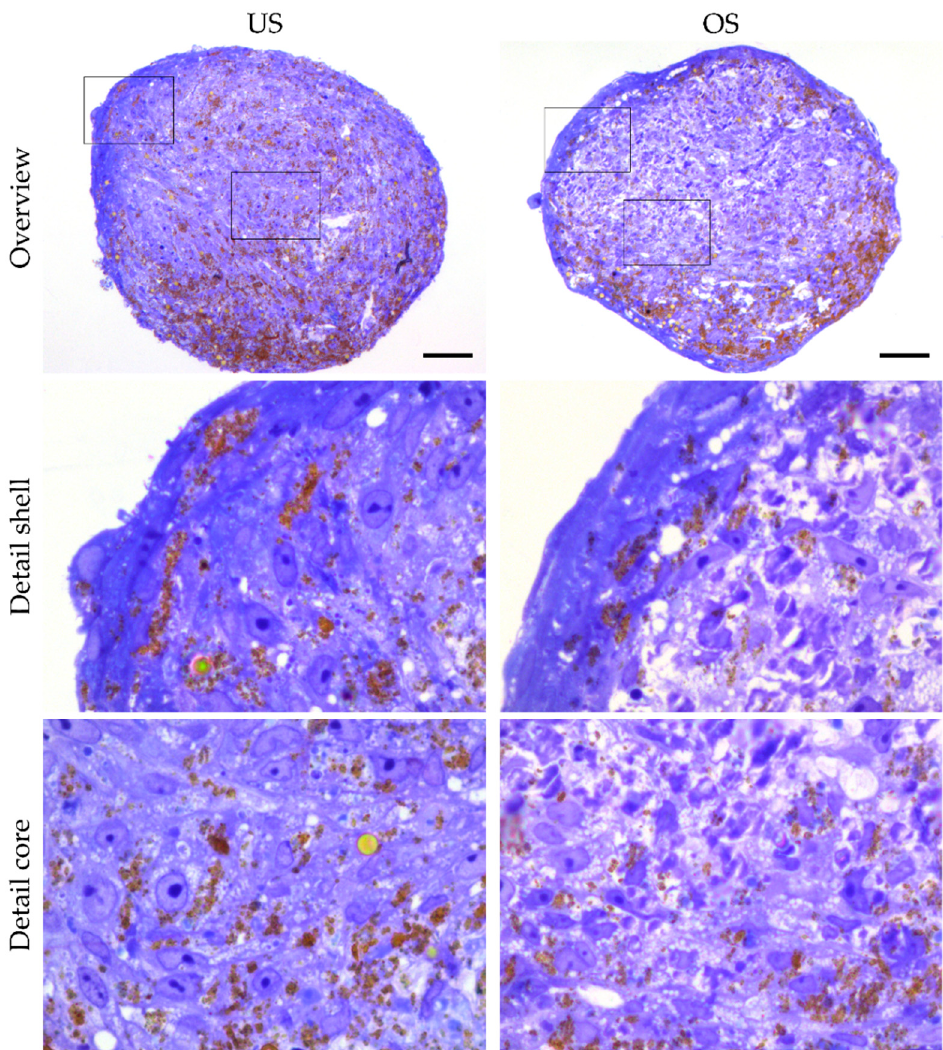
Figure 4. Representation of 3D spheroids by overview staining of thin sections with toluidine blue. Overview images of an unstimulated (US) spheroid and an osteogenically (OS) stimulated spheroid after 14 days ( top panel). Frames in the overview images correspond to the areas shown below in high magnification. Details of the shell and core regions of the same spheroids show differences in cell arrangement, cell shape, and cellular spacing ( middle and bottom panels) (scale bars represent 50 µm for the overviews and 10 µm for the detailed magnifications, respectively).